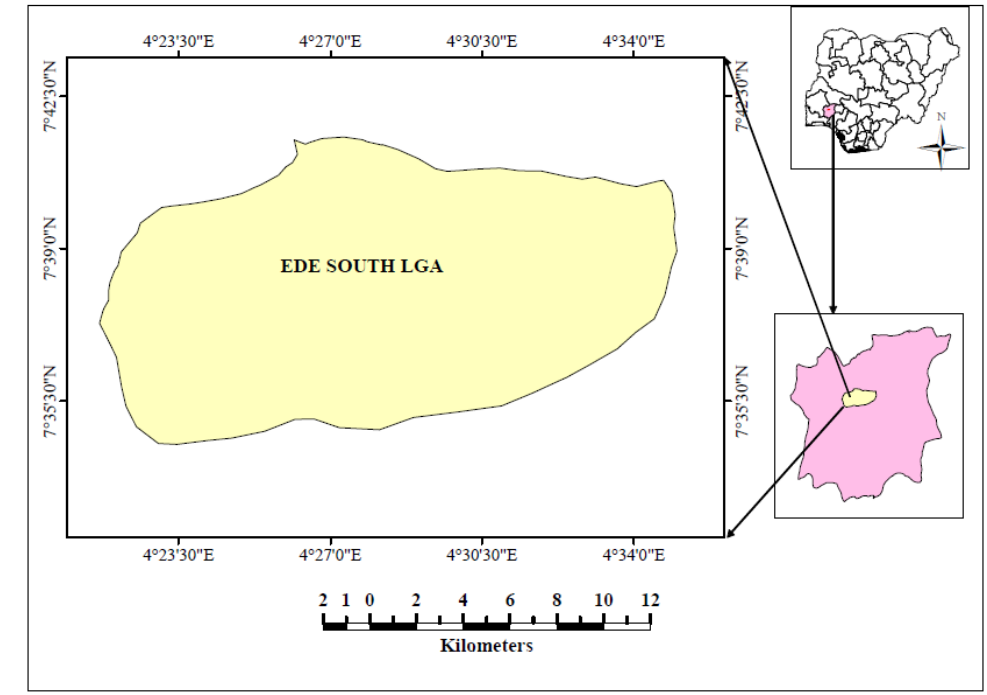
Figure 1. Ede South Local Government Area of Osun State, Nigeria.